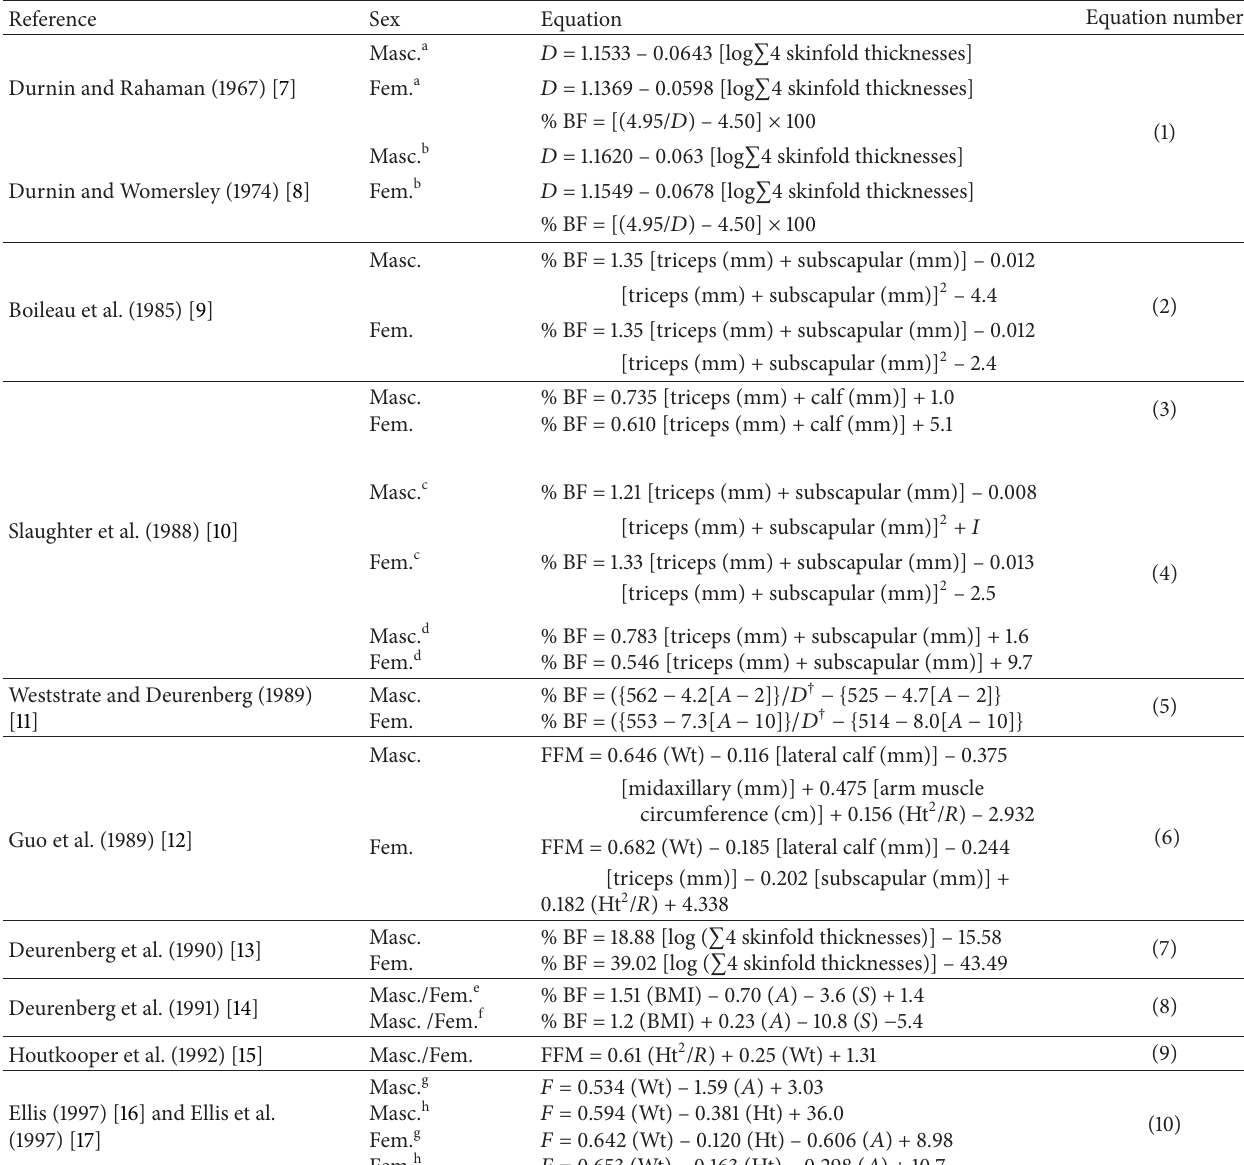
Table 1: Body fat and fat-free mass anthropometric